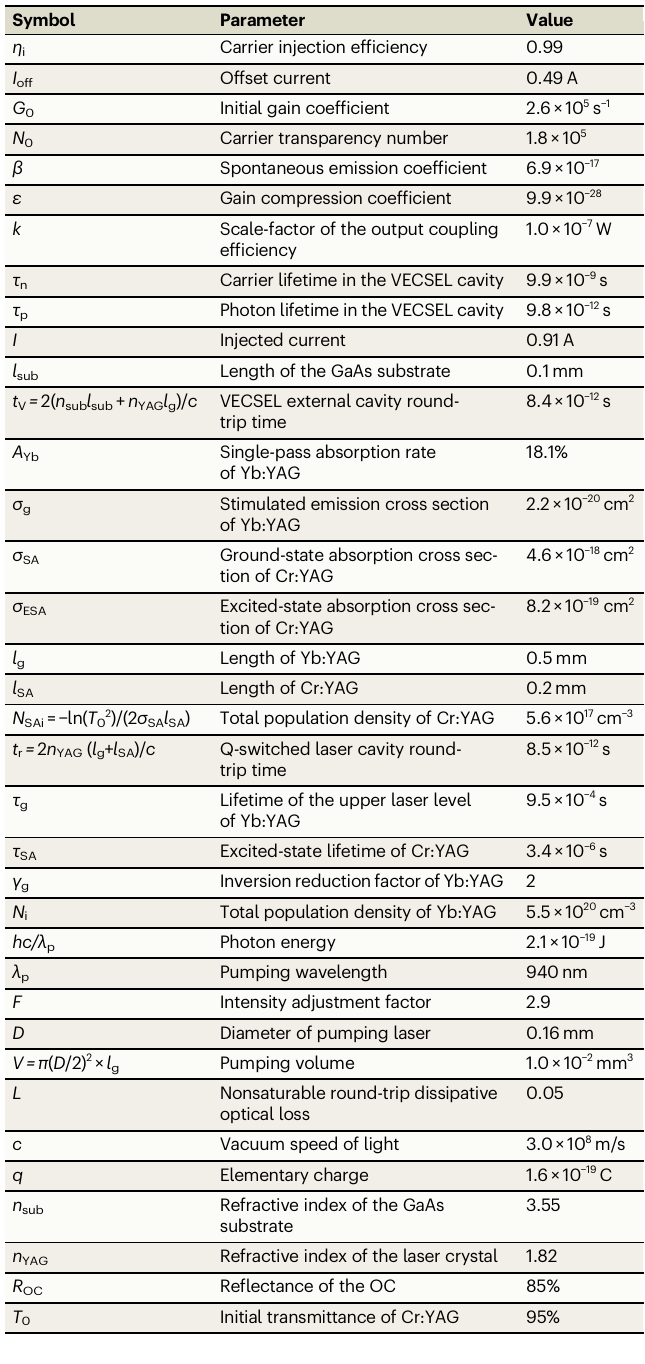
Table 1 | Parameters used for simultaneous rate equations model